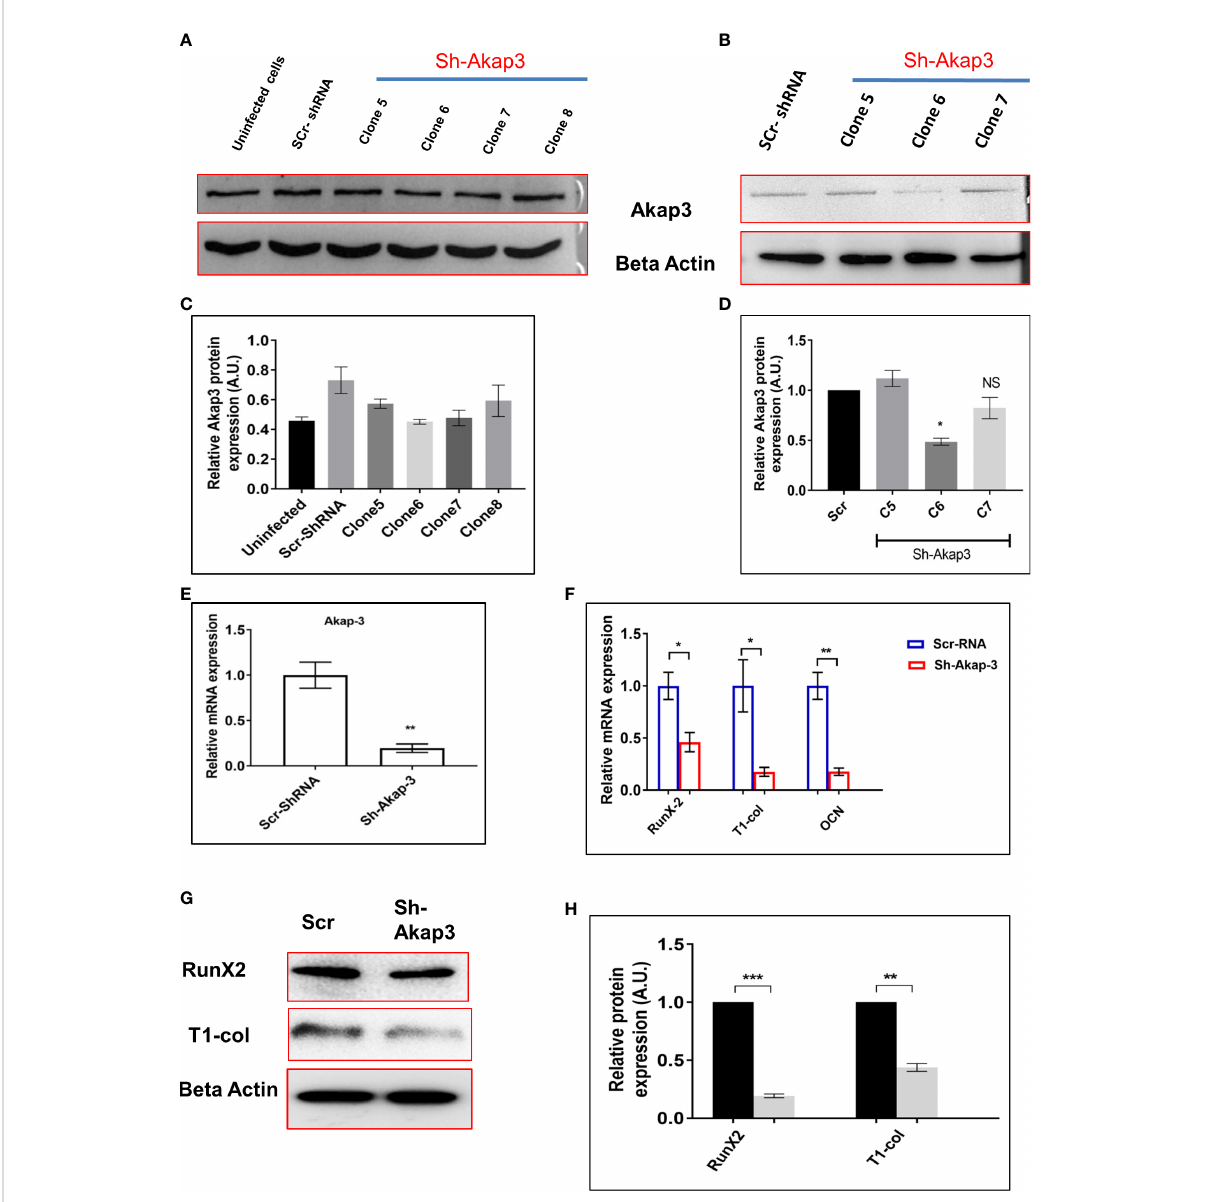
FIGURE 9 Effect of Akap-3 knock down on osteoblast proliferation. (A) Akap-3 protein level in 3T3 cells transduced with control shRNA or Akap-3 shRNA as determined by western blot using whole cell lysates. Data are expressed in mean ± SEM (n=3) *P < 0.05 compared with control scr shRNA (B) Western blot analysis of Akap-3 protein level in MCO cells shAkap-3 clones transduced with control shRNA. Values are expressed in mean ± SEM (n=3) *P < 0.05 compared with control scr shRNA. (C, D) quanti fi cation of blots by using ImageJ software. (E) m-RNA expression of Akap-3 gene in control vs shAkap-3 treated MCO cells. Values (mean ± SEM; n=4) **P < 0.01 compared with control scr-shRNA. (F) The expression of osteogenic marker genes (RunX-2, T-1-col and OCN) was evaluated in control and Akap-3 shRNA MCO treated cells using qRT-PCR. Data normalized with expression of internal control GAPDH. (G) The protein expression of osteogenic markers (RunX-2, T-1-col and OCN) was evaluated in control and Akap-3 shRNA MCO treated cells using western blots. (H) Densitometry analysis of blots. All values (mean ± SEM; n=3) *P < 0.05, **P < 0.01, ***P < 0.001, and NS, non-signi fi cant compared with control